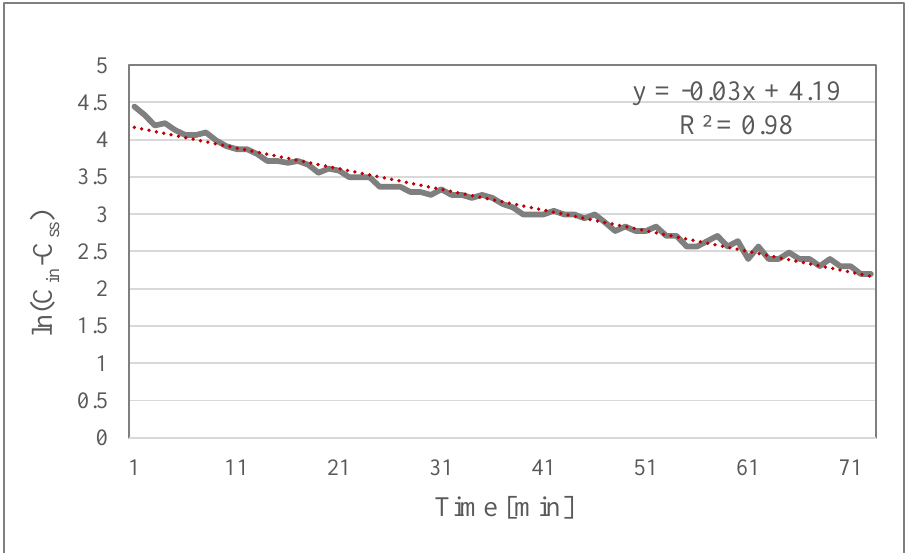
Figure 5. Typical particle natural decay curve for estimating deposition rate ( k ).